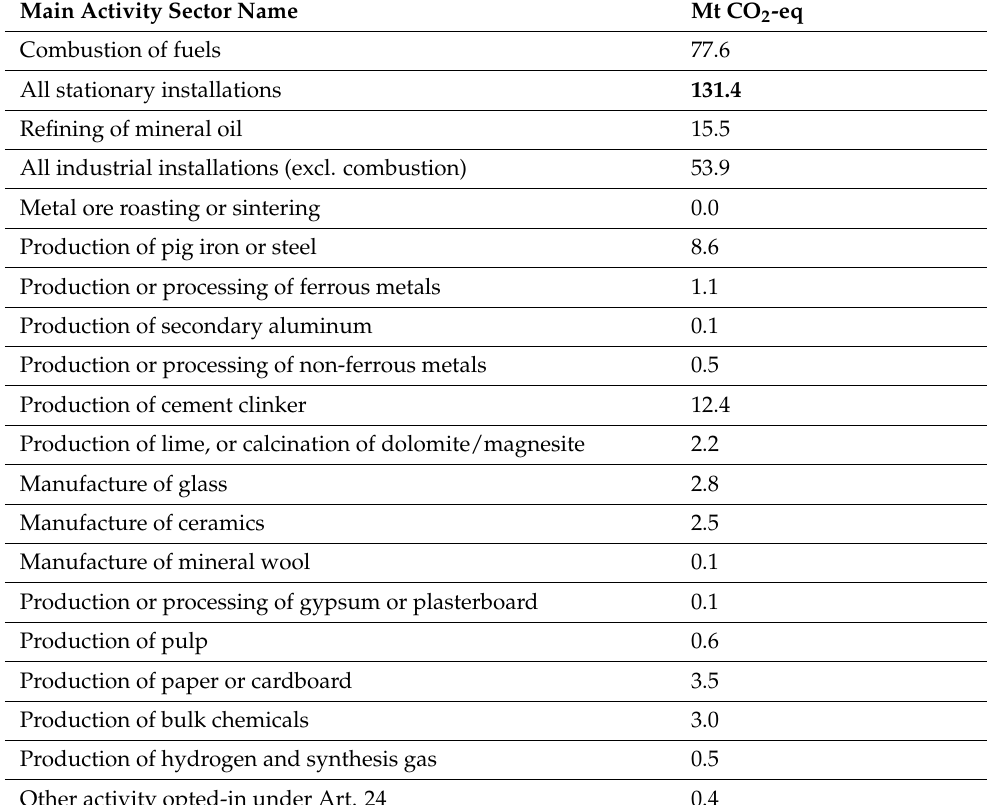
Table 1. Verified emissions of ETS sectors in Italy as for the 2021.